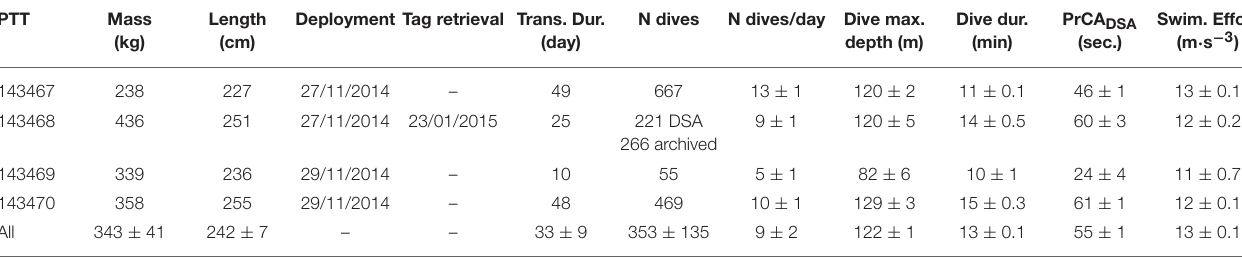
TABLE 1 | General information on tag deployment and transmission outputs. PTT Mass Length Deployment Tag retrieval Trans. Dur. (kg) (cm)